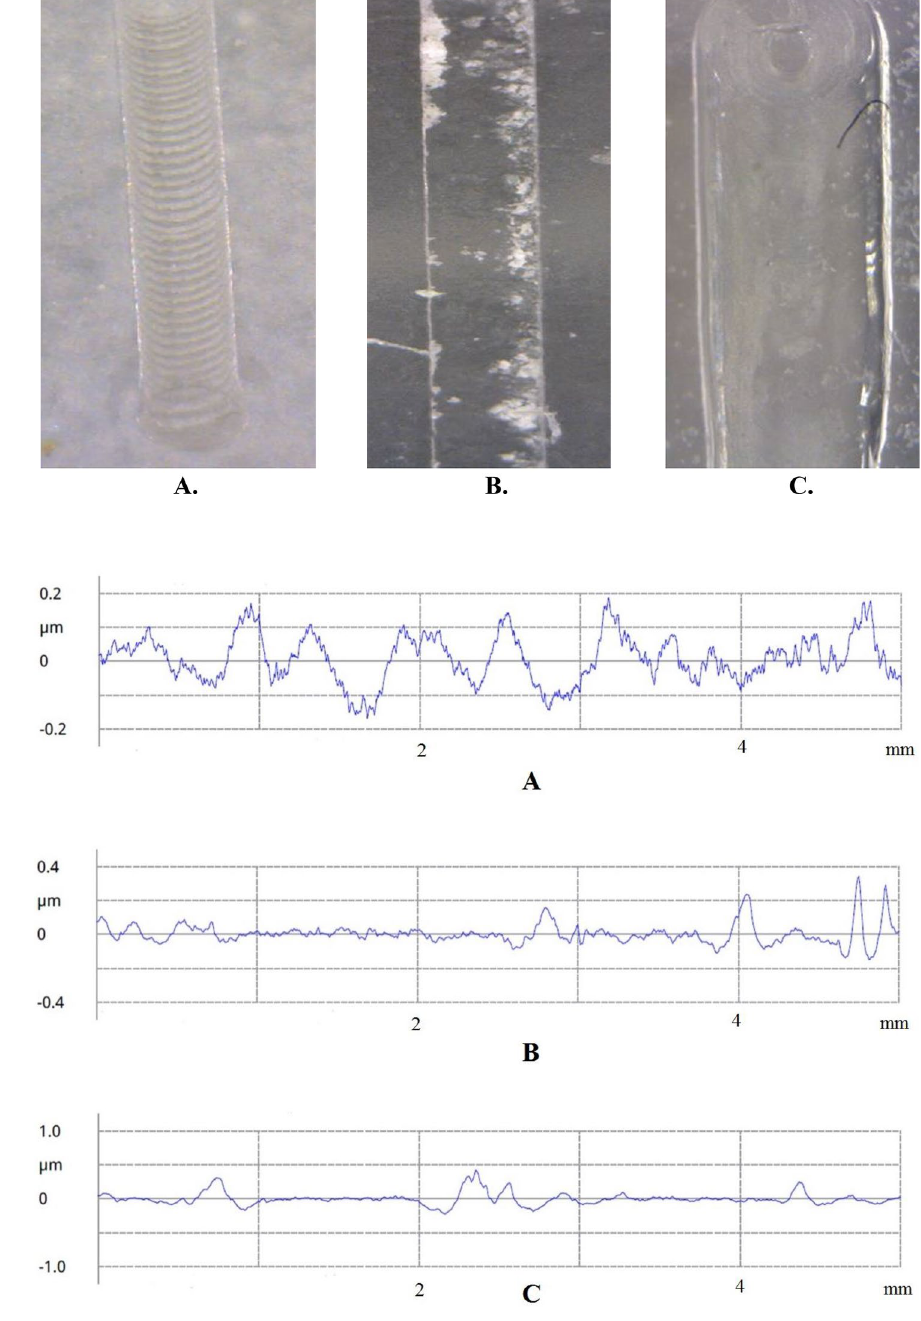
Fig. 18 Effect of voltage changes in channels created under conditions of zero rota- tional speed, 25% concentra- tion and feed rate of 0.6 mm/ min at voltages a 38 V, b 40 V and c 42 V